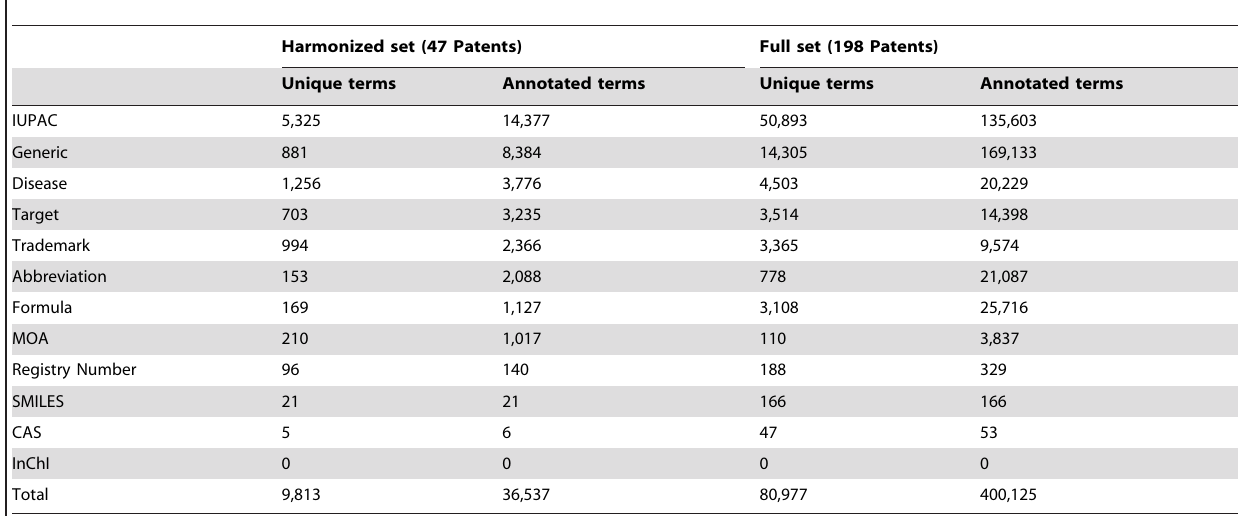
Table 7. Number of annotated terms and unique terms in the harmonized set and in the full patent set of the gold standard corpus after